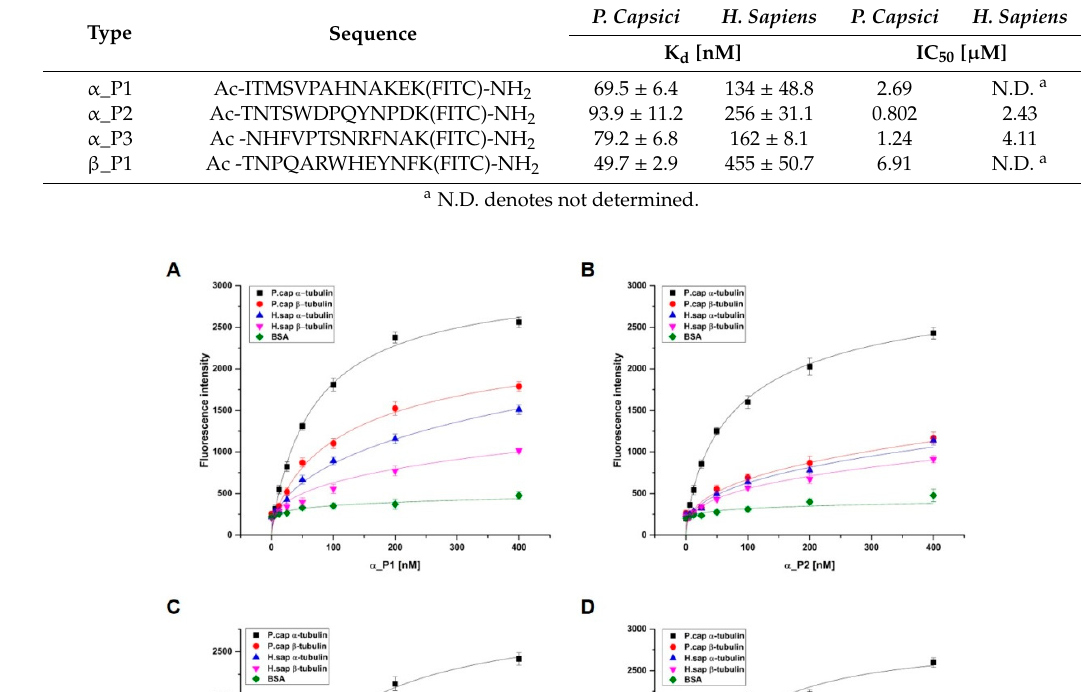
Table 2. Binding a ffi nity and inhibitory potency of the modified peptides against P. capsici and H. sapiens α , β -tubulin.